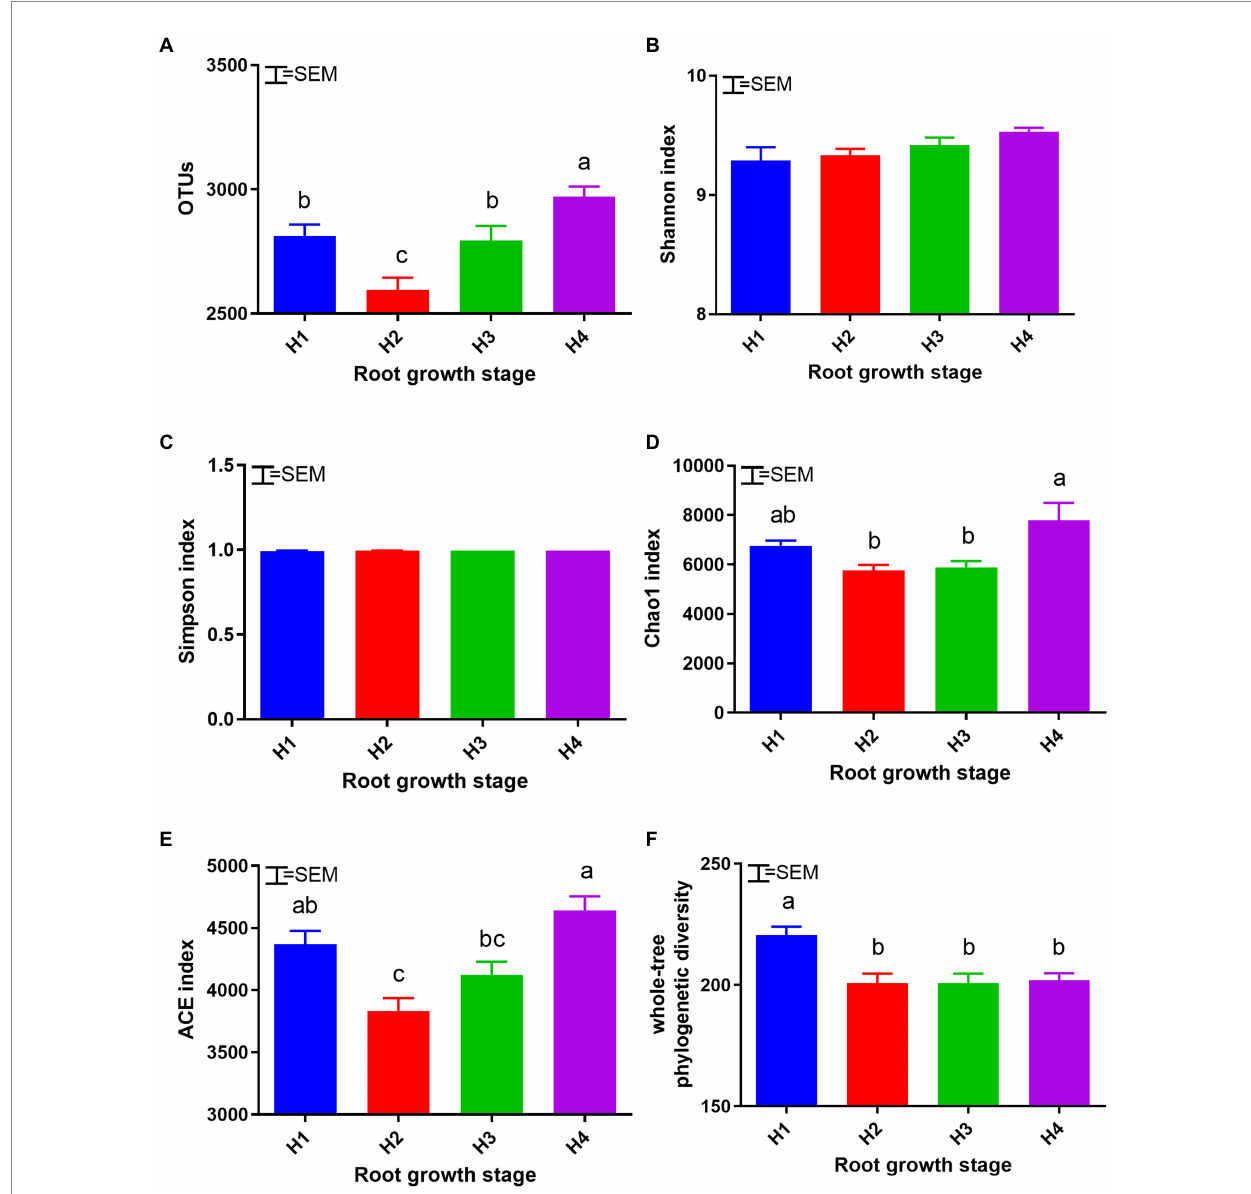
FIGURE 2 Soil bacterial alpha diversity: OTUs (A) , Shannon (B) , Simpson (C) , Chao 1 (D) , ACE (E) , and whole-tree PD (F) at root growth stages H1–4. H1–4, root growth stages of mixed forage: January 4 (H1), March 14 (H2), April 21 (H3), and May 19 (H4). SEM, standard error of the mean ( n = 18). Means with difference superscripts differ significantly ( p <